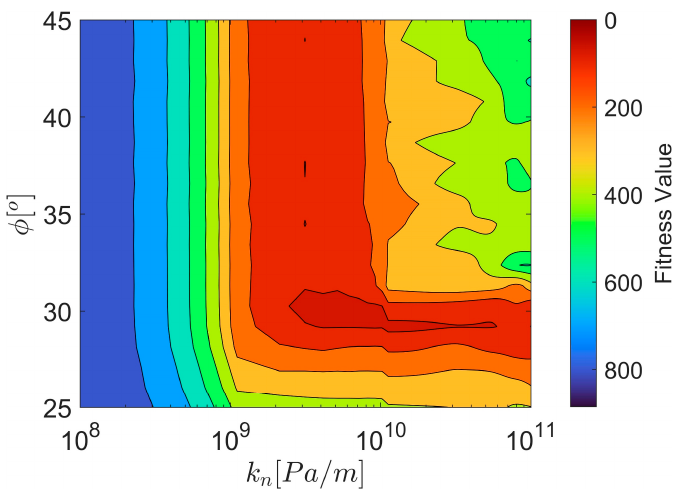
Figure 12. Fitness values for varying interparticle friction ϕ (°) and normal stiffness k n (Pa/m) parameters calculated by Objective Function 1.